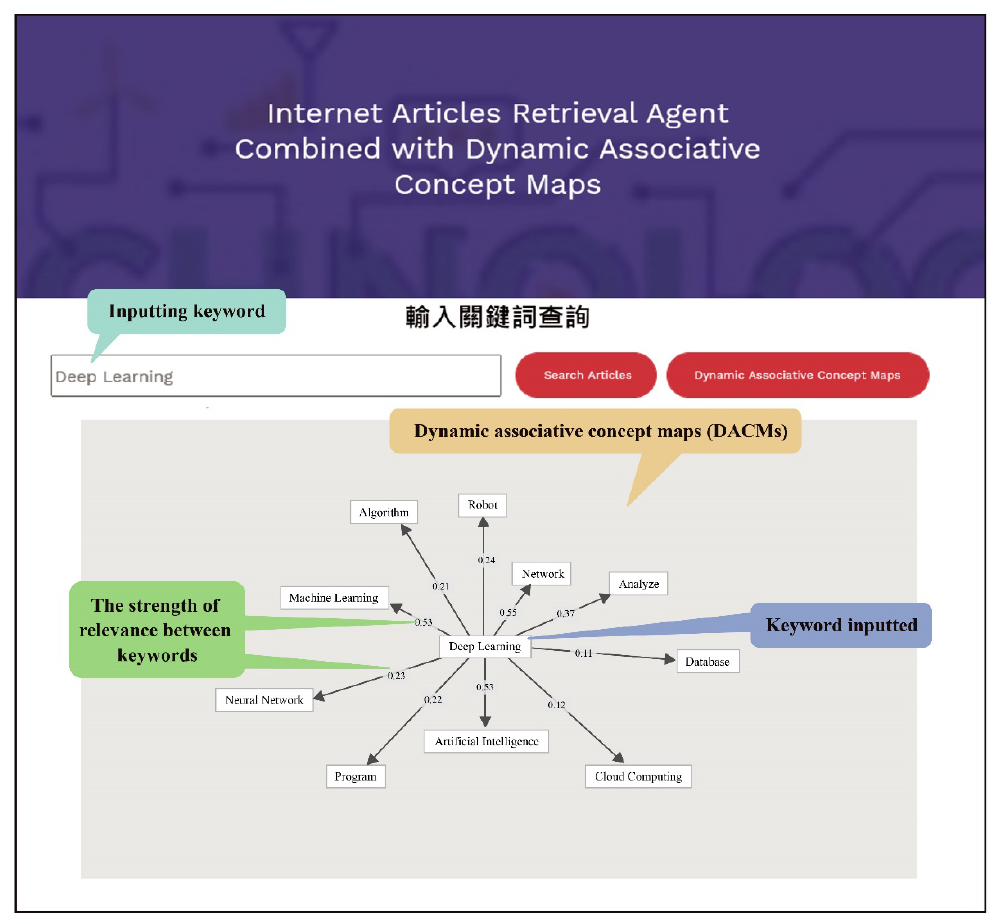
Sample Dynamic Associative Concept Map (DACM) for the Keywords Deep